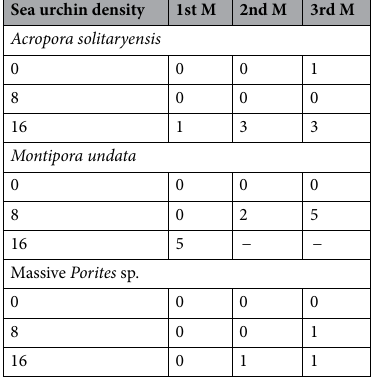
Table 1. Coral fragment mortality. The table presents the cumulative number of dead coral fragments (n = 5 replicates) in each Diadema savignyi density condition (indiv. m −2 ) by the 1st, 2nd and 3rd month observations. Horizontal bars in M. undata indicate the termination of observation due to 100% mortality by the 1st month.